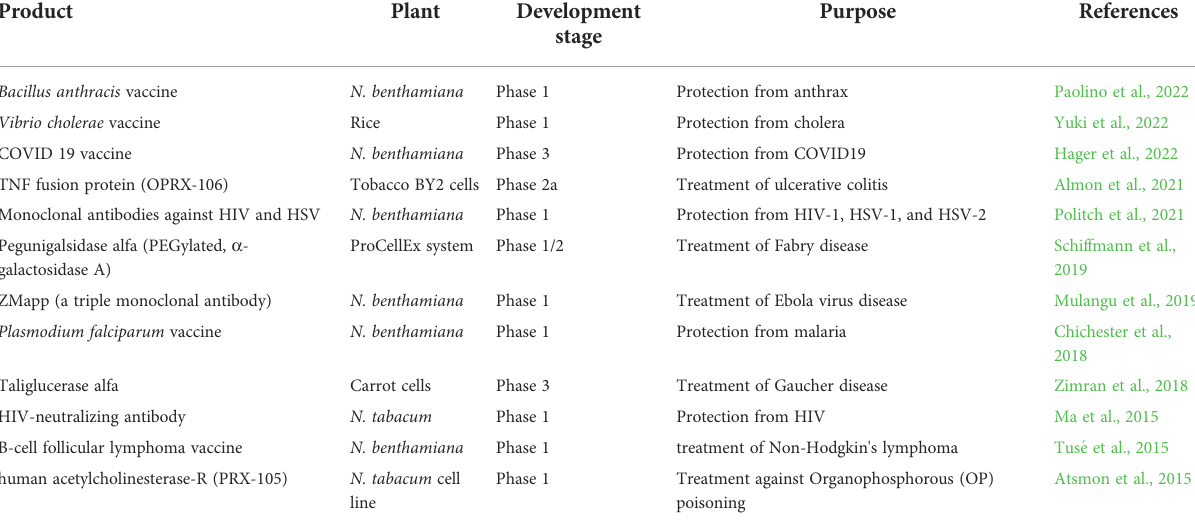
TABLE 1 Examples of plant-made vaccines, antibodies, and enzymes at various human clinical stages.